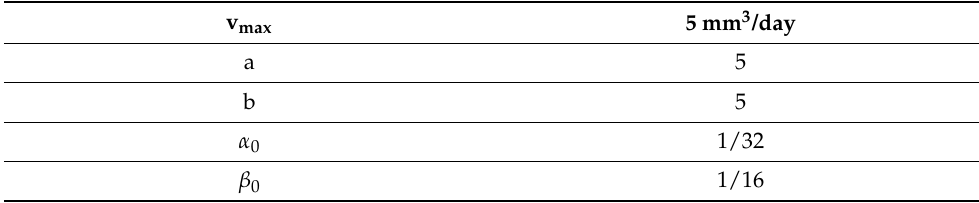
Table 2. Values of the parameters of the sigmoid-like function.